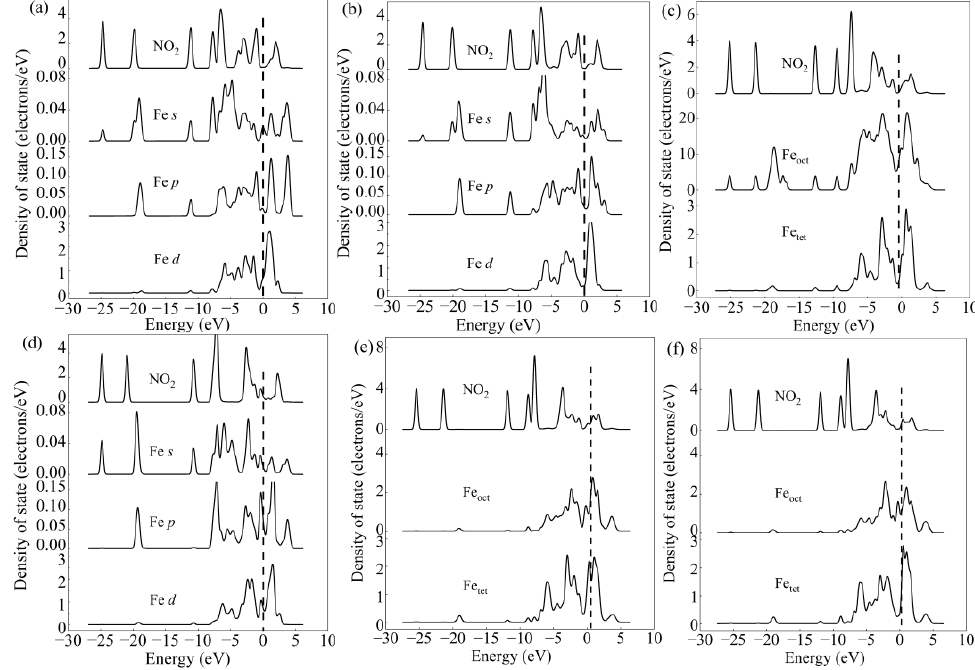
Figure 6. The PDOS for the system before and after NO 2 adsorption on the γ -Fe 2 O 3 (111) surface. PDOS of configuration 2A ( a ), PDOS of configuration 2B ( b ), PDOS of configuration 2C ( c ), PDOS of configuration 2D ( d ), PDOS of configuration 2E ( e ), PDOS of configuration 2F ( f ).